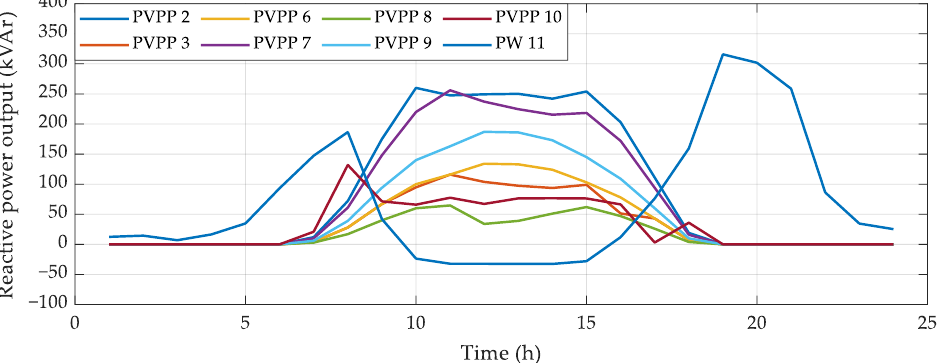
Figure 8. Reactive power output for the distributed sources for the selected day.